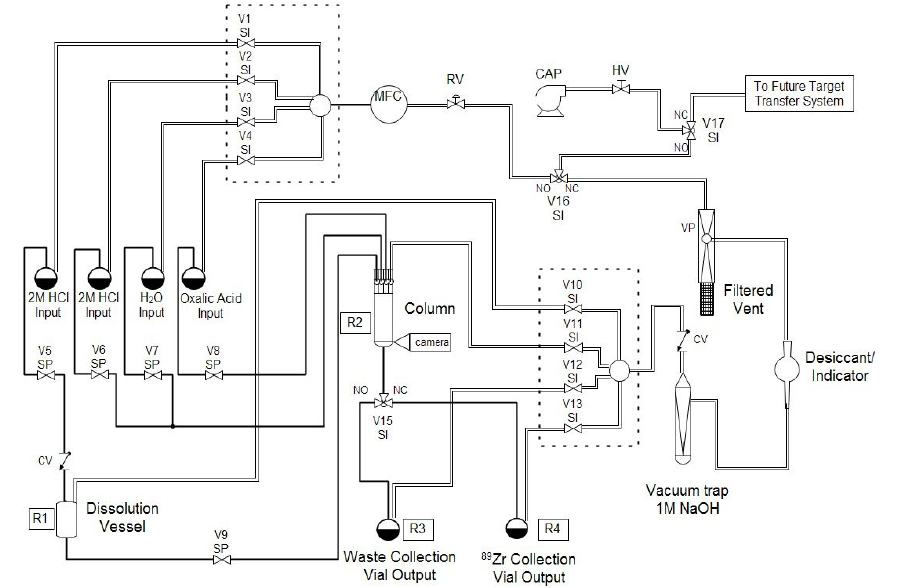
Figure 3. Process flow diagram for the automated module used for chemical separation